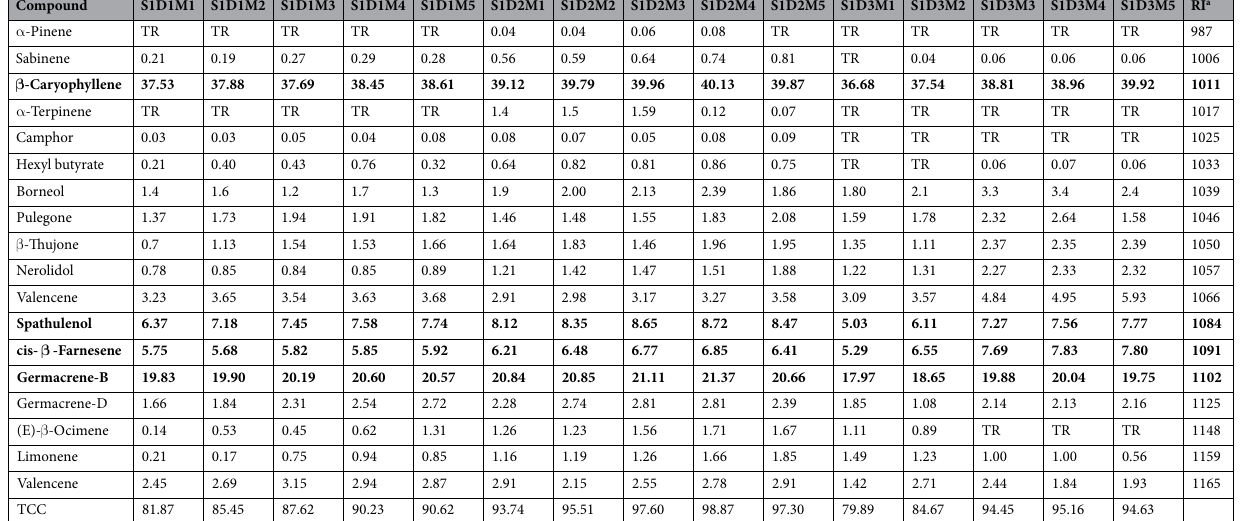
Table 3. Essential oil compound of Salvia nemorosa L., under different irrigation regimes and melatonin treatments. S1: Salvia nemorosa L. D1: irrigation at 80% Fc, D2: irrigation at 60% Fc, D3: irrigation at 40% (200 µ M melatonin). a The data were sorted based on the Retention Index (RI) of components. TR = trace, less than 0.01%., TCC = Total chemical composition